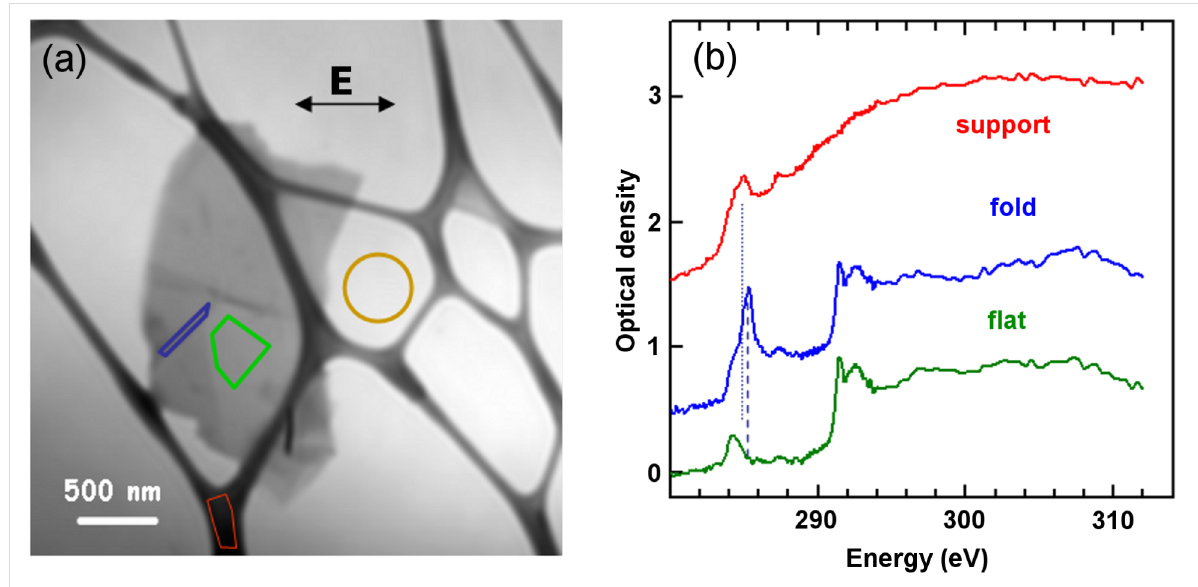
Figure 2: (a) Average of aligned TXM images (283–311 eV). (b) Spectra extracted from the three regions indicated by the coloured shapes in part (a): red is from the lacey carbon support, green is from the flat area of the sample, while blue is from the folded region. The signal intensity used to convert the measurements to optical density (OD) was taken from the yellow circular area. Offsets of 0.5 (blue) and 1.5 (red) OD have been used for